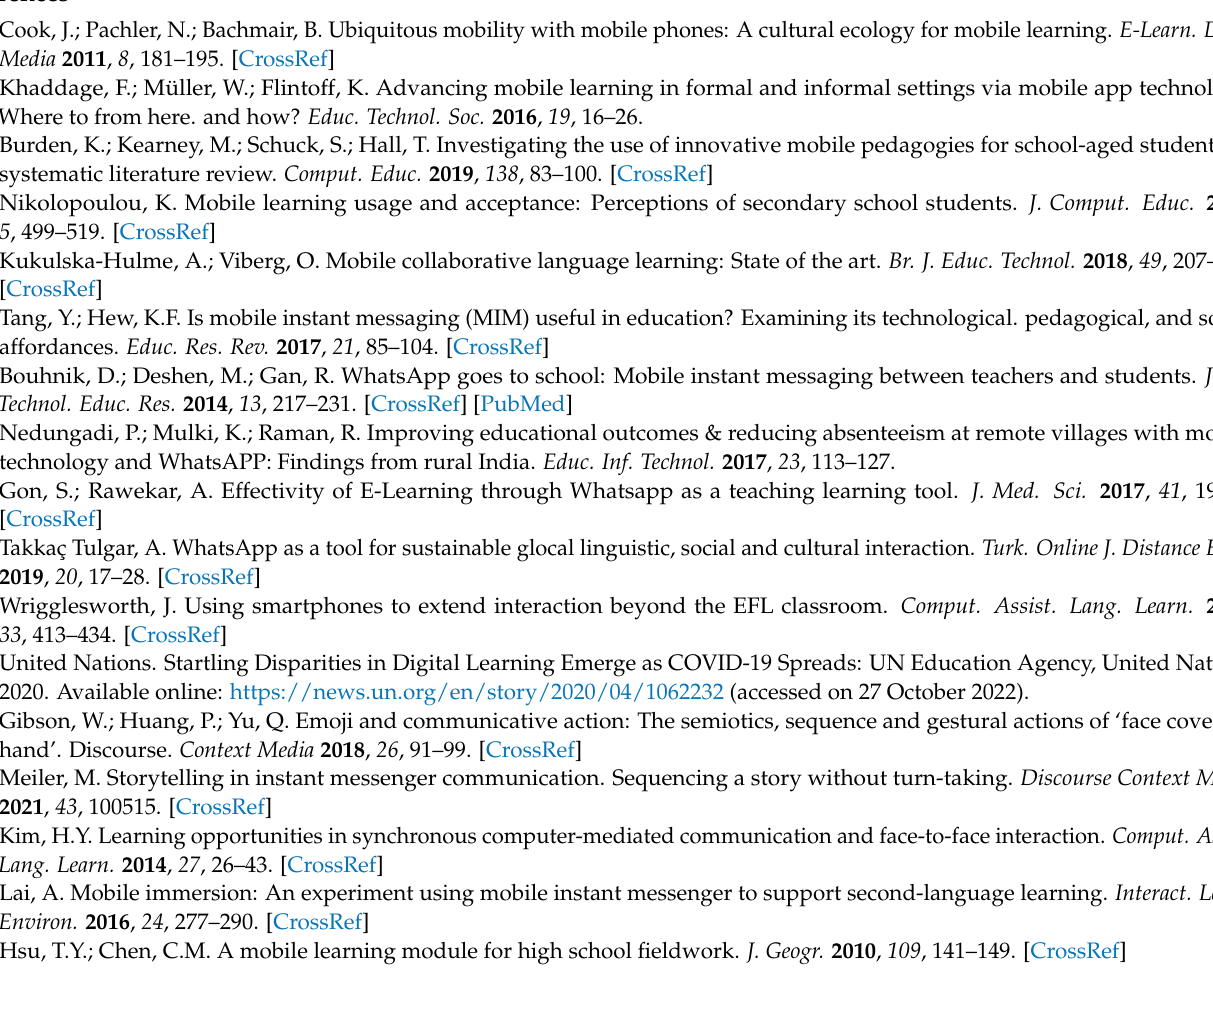
Figure 3 compared with Figure 2). Visualization of more complex and multimodal online conversations requires further attention from researchers as